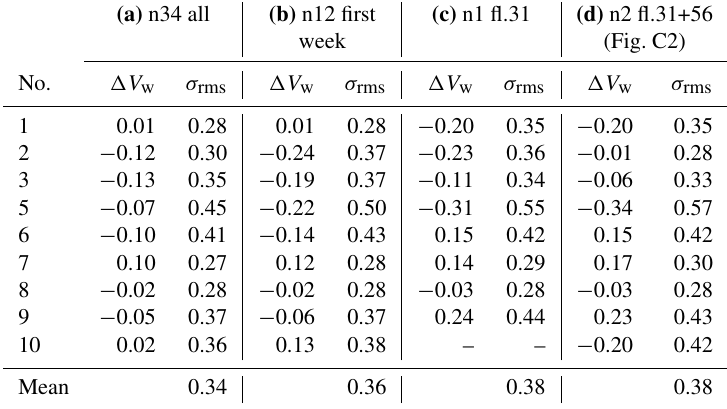
Table C2. Accuracy of wind speed measurements in meters per second (ms − 1 ) for different calibration data using only pitch offset applied to the validation dataset of 12 flights from the second week. The wind speed accuracy is based on 2min time-averaged data. Data used for calibration: (a) all possible drone tower flight patterns (34 flights); (b) only flights from the first week (12 flights); (c) only one single flight with flight number 31; (d) two flights with flight number 31 and